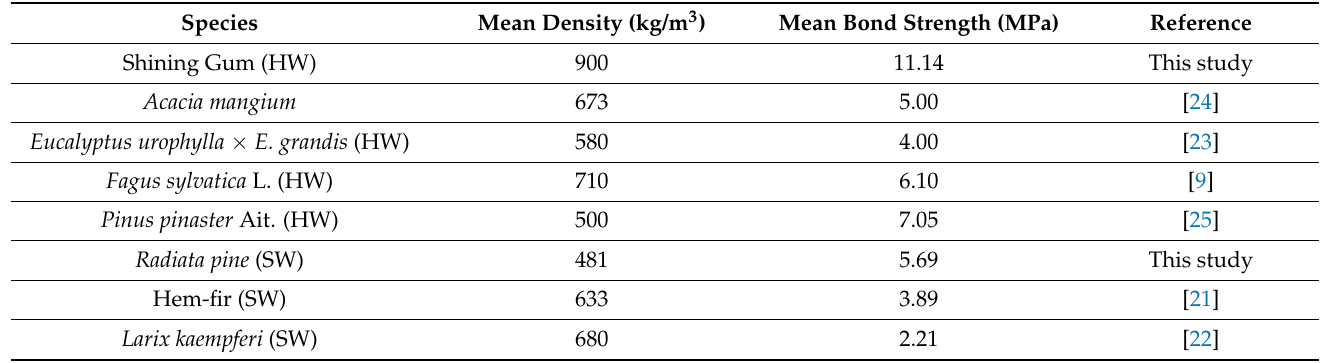
Table 6. Bond strength of various species when the grain directions of the boards are parallel to each